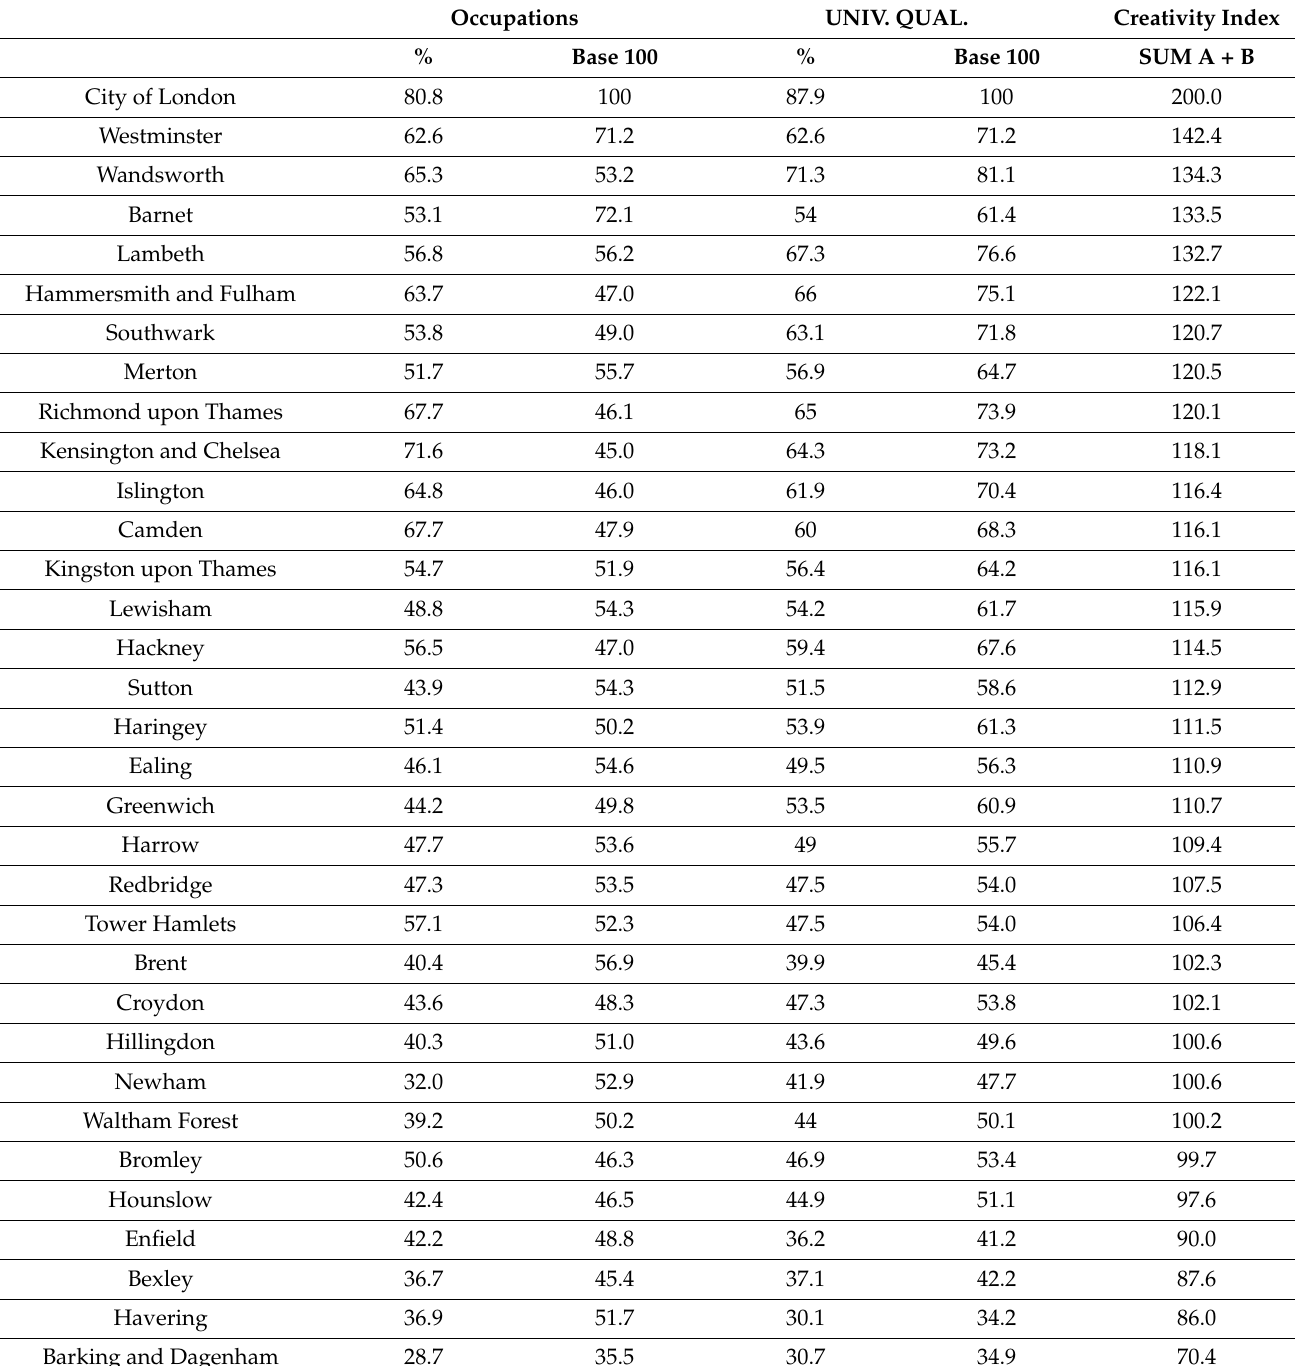
Table 3. Creativity Index—London